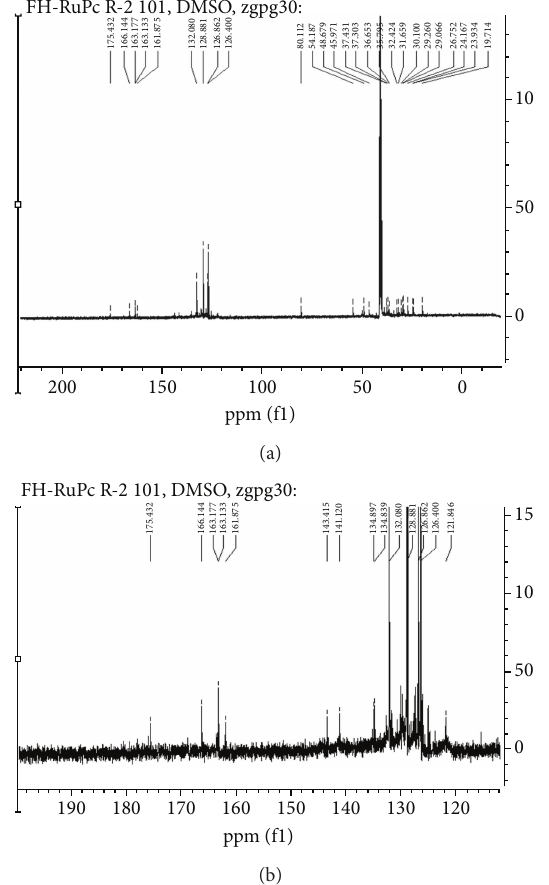
Figure 5: (a) 13 C NMR spectrum of C 3 R 󸀠󸀠 RuPc . (b) Aromatic region of 13 C NMR spectrum of C 3 R 󸀠󸀠 RuPc .